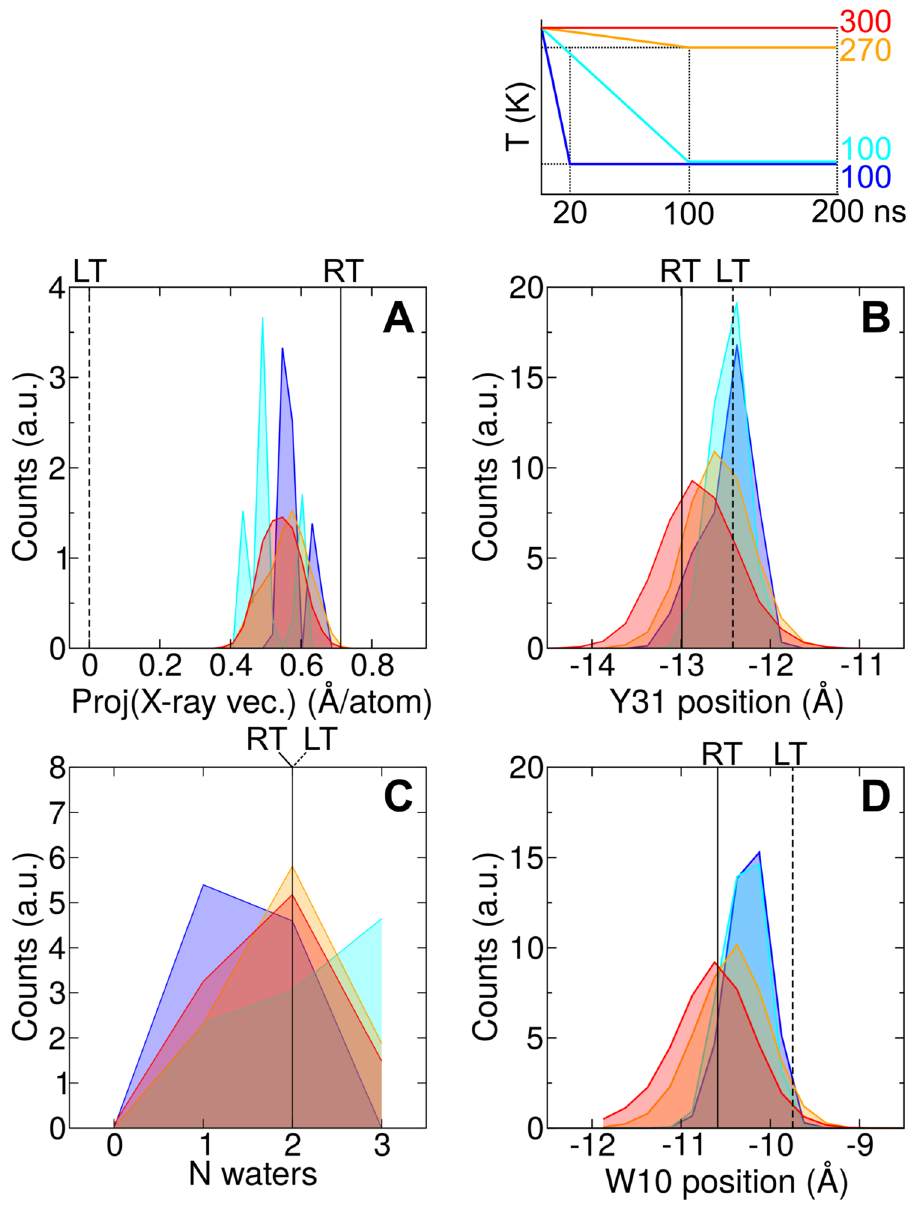
Figure 6. Aqy1 freezing simulations. Histograms of distinct quantities extracted from freezing MD simulations of Aqy1 are displayed. ( A ) Projection along the X-ray vector connecting the LT and RT structures. ( B ) Position of the Tyr31 OH atom along the pore coordinate with respect to the NPA region. ( C ) Number of waters coordinated by the asparagine residues Asn112 and Asn224 in the NPA region. ( D ) Position of the water molecule at crystallographic position Wat10 with respect to the NPA region. Vertical lines represent the values observed in the X-ray structures. Temperature was reduced from an initial value of 300 K to different values as indicated by the time-trace at the top. Histograms were computed during the last 80 ns of the simulations when the final temperature (different colors) had been reached. Histograms shown here correspond to the AMBER99SB * -ILDN-TIP3P force-field (see complete set of histograms for all force-fieds in Fig.